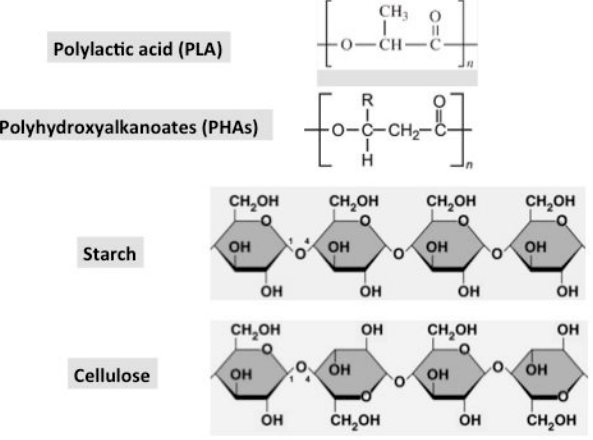
Figure 4. Main biopolymers currently used as bioplastics